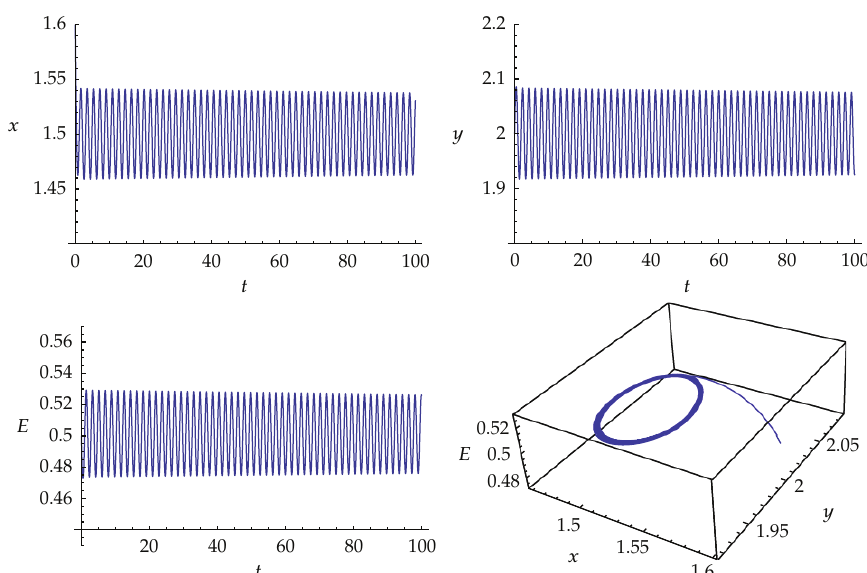
Figure 2: Dynamic behavior of the di ff erential-algebraic system (cid:6) 3.1 (cid:7) with τ (cid:5) 0 . 563 < τ (cid:8) solutions bifurcating from the positive equilibrium point P (cid:8) .